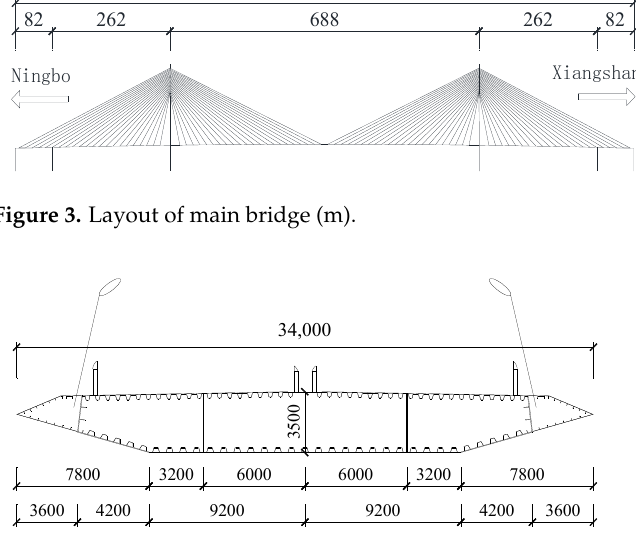
Figure 4. Cross ‐ sectional layout of steel box girder (mm).